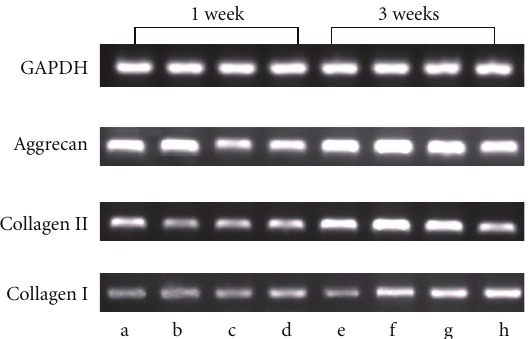
Figure 4: Agarose gel electrophoresis of the PCR products obtained from chondrocyte-seeded alginate hydrogel cultured in (a,e) medium supplemented with 1% ITS plus 2% FBS, (b,f) medium supplemented with 1% ITS plus 4% FBS, (c,g) medium supplemented with 1% ITS plus 8% FBS, or (d,h) medium with 10% FBS. Three target genes, aggrecan, type I, and II collagens were examined, while GAPDH was used as a housekeeping gene. Samples for lane a–d were cultured for 1 week and for lane e–h were cultured for 3